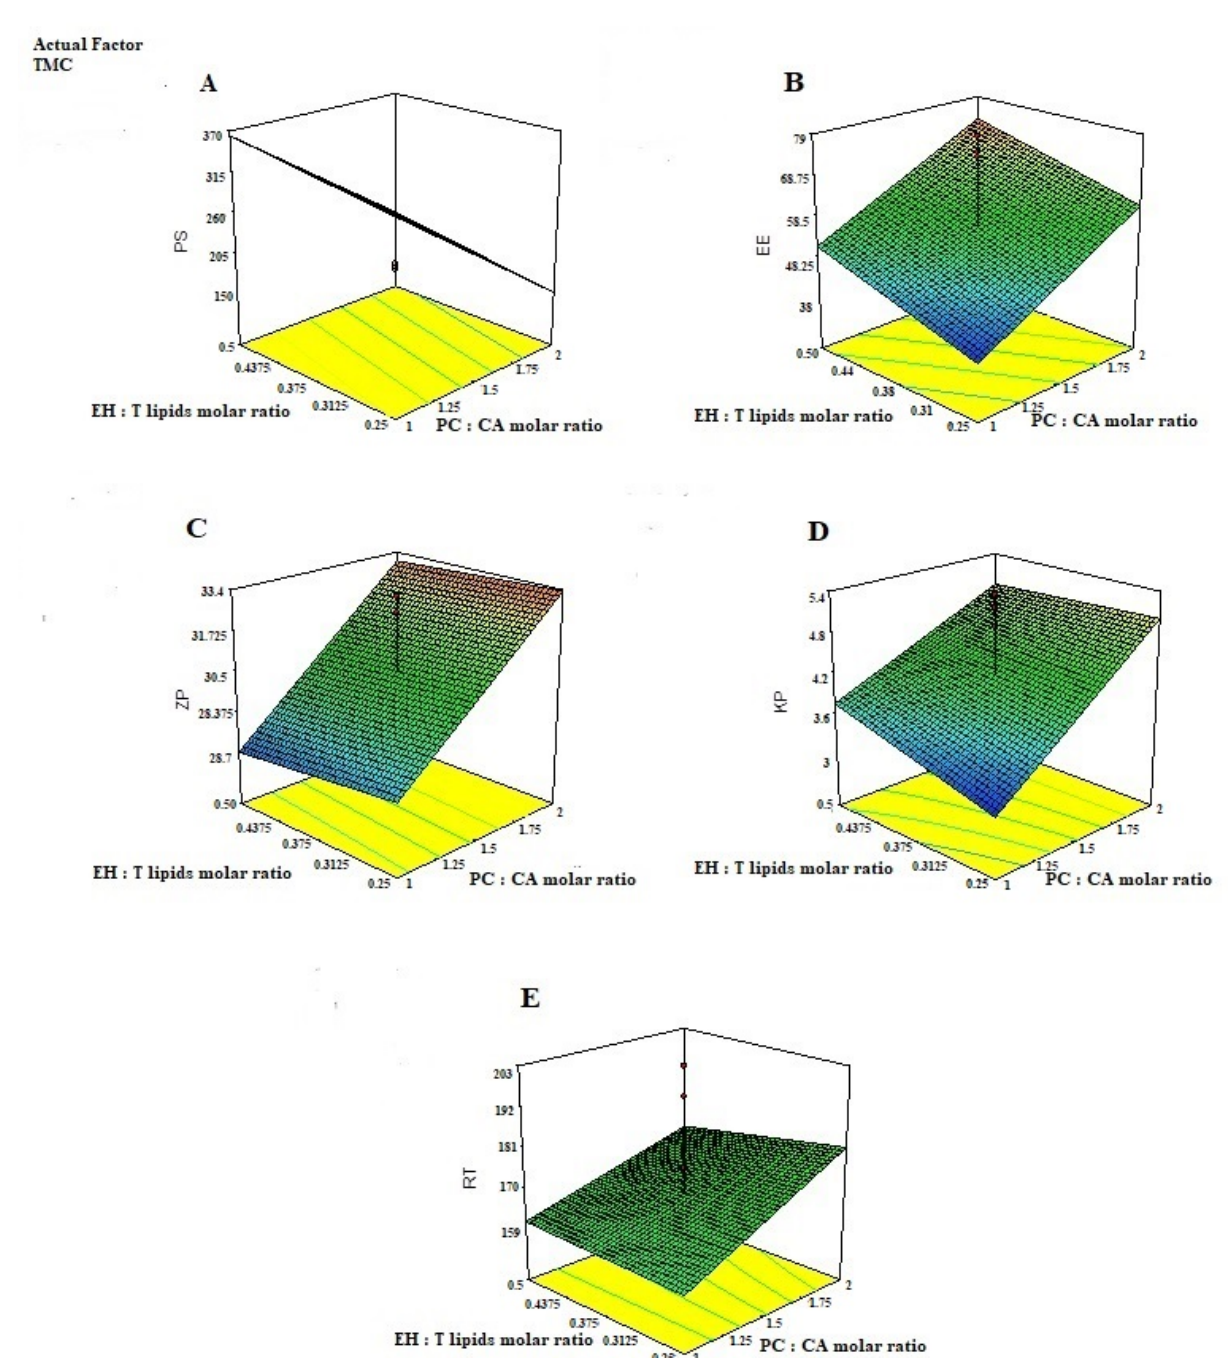
Figure 2. 3D-plots response for studying the effect of PC: CA molar ratio, EH: T. lipids molar ratio, and TMC conc on; ( A ) the particle size PS, ( B ) entrapment efficiency, ( C ) Zeta potential (ZP), ( D ) Permeability Coefficient (Kp), and ( E ) Residence time (RT) of EH-mucoadhesive